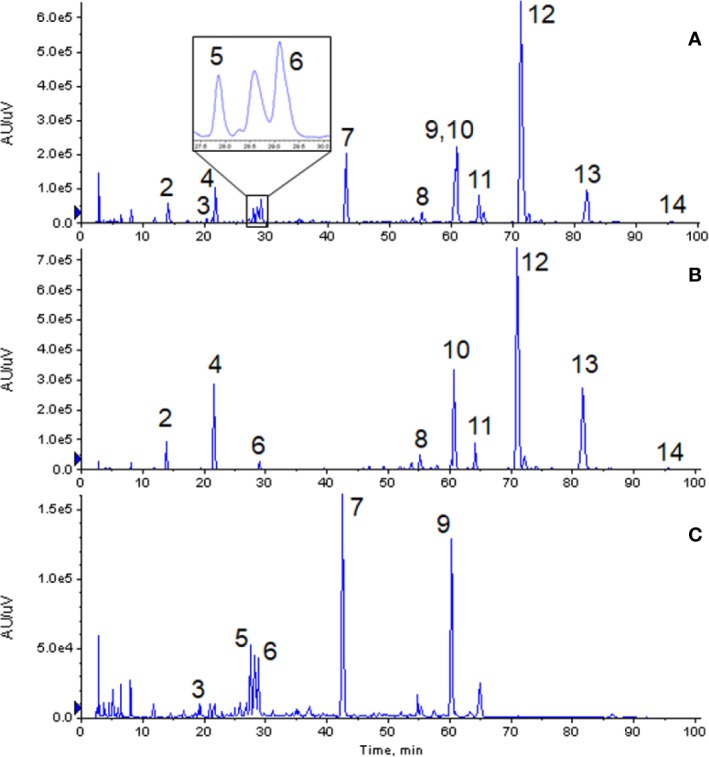
Comparison of chromatogram of each extract at 280 nm. (A) Ultraviolet chromatogram of GXNT. (B) Ultraviolet chromatogram of Danshen. (C) Ultraviolet chromatogram of Chuanxiong. (2) Tanshinol; (3) Senkyunolide B; (4) Protocatechualdehyde; (5) Chlorogenic acid; (6) Caffeic acid; (7) Ferulic acid; (8) Salvianolic acid D; (9) Senkyunolide I; (10) Rosemary acid; (11) Isosalvianolic acid A; (12) Salvianolic acid B; (13) Salvianolic acid A; (14) Isosalvianolic acid C.